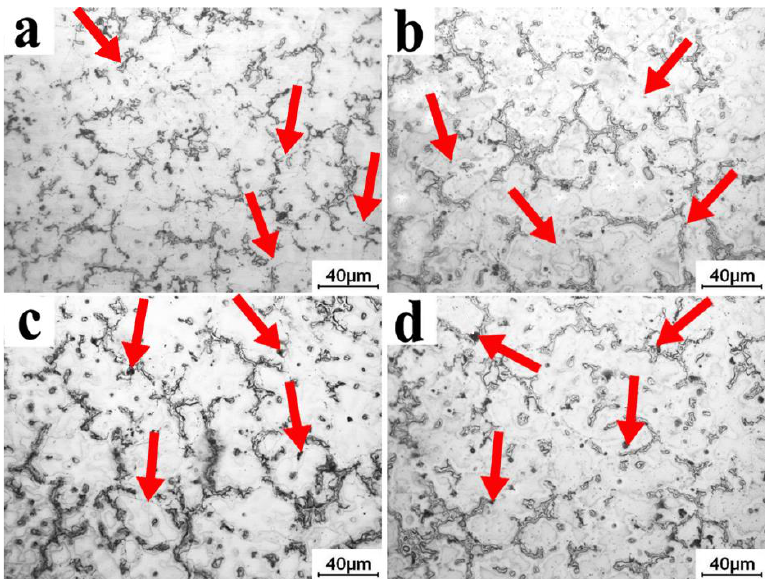
Figure 14. The location of Grp in the Grp/AZ91D composites with different holding times: ( a ) 5 min, ( b ) 15 min, ( c ) 20 min, and ( d ) 30 min. (Red arrows: the particles of Grp).